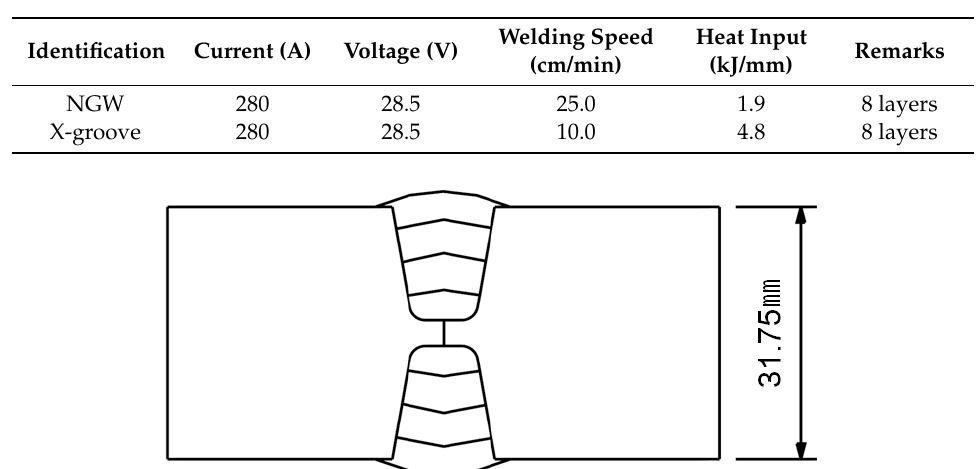
Table 3. Welding parameters of NGW and X-groove. NGW: narrow gap welding.